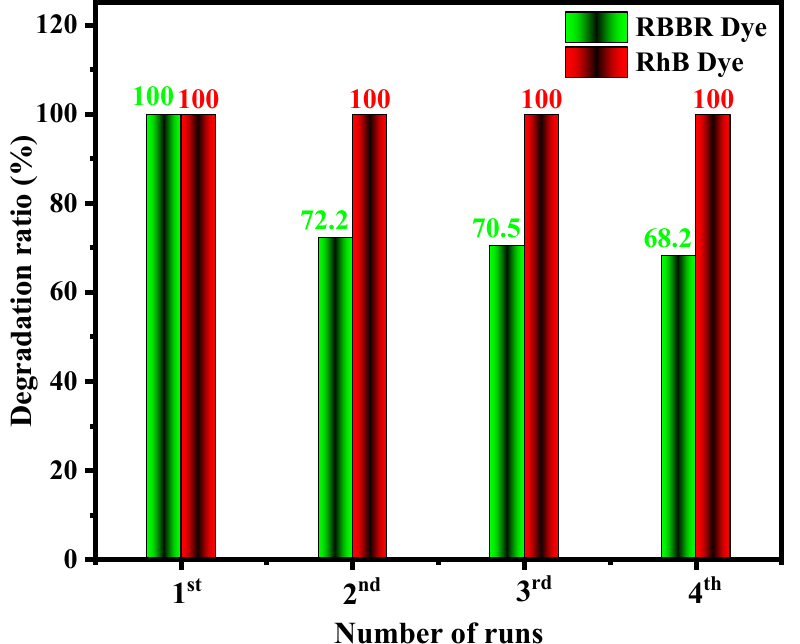
Figure 9. Catalytic performance of the PbMoO 4 nanocrystals in the photodegradation of ( a ) cationic (RhB) and an ( b ) anionic dye (RBBR) with the presence and absence of scavenger radicals (OA, PBQ and TBA).